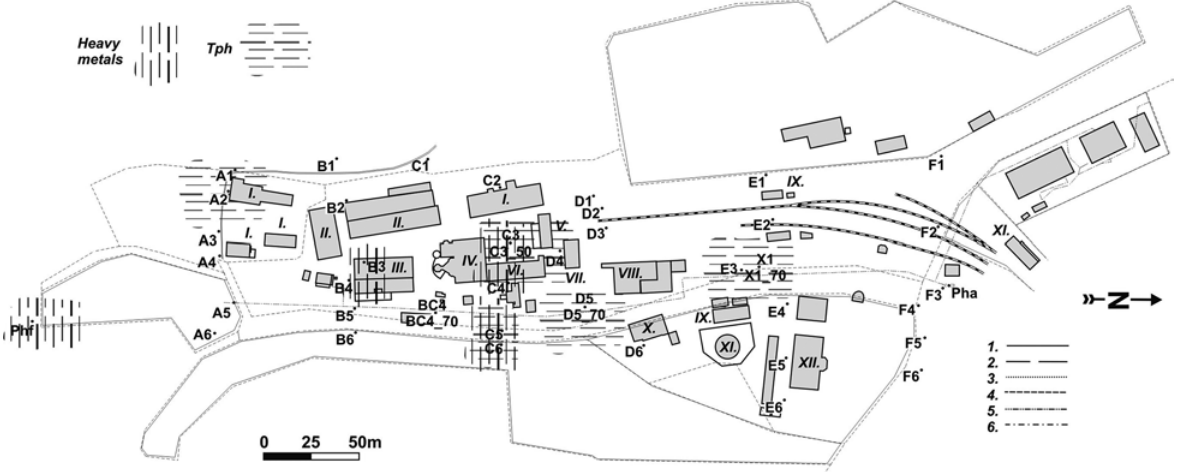
fig. 9. the contaminated areas. legend: i – storage units; ii – fitting room; iii – engine-room; iV – stokehold; V – coal-bunker; Vi – dryer; Vii – coal-preparatory; Viii – briquette-press; iX – pump-stations; X – transformer station; Xi – bitumen tank; Xii – offices; A1–f6 and Pha–Phf are sample